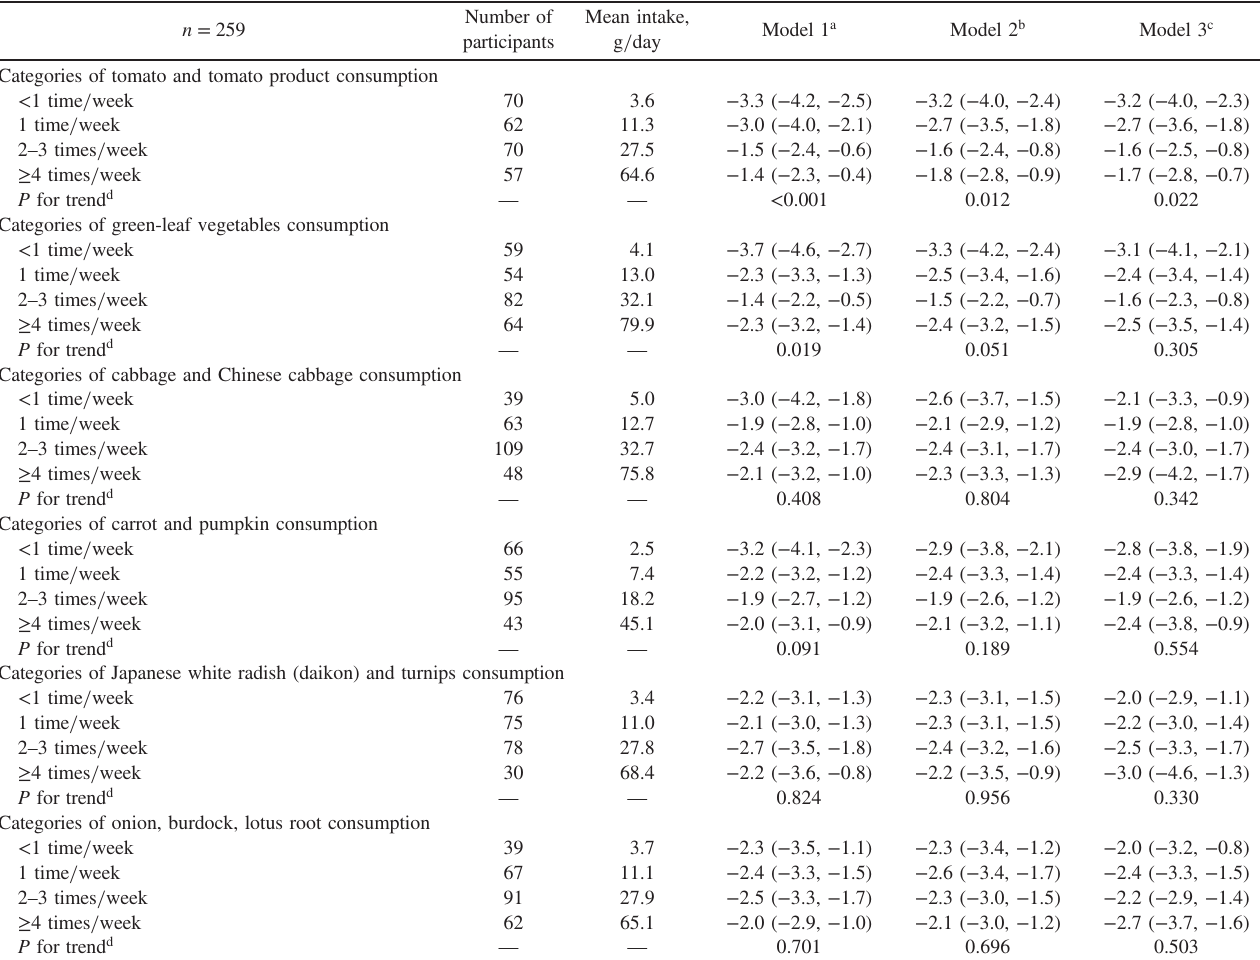
a Model 1: Adjusted for age (continuous variable) at baseline. b Model 2: Adjusted for the variables in model 1 and sex (categorical variable), occupation (categorical variable: desk work or not), smoking status (categorical variable: never, former, or current), drinking frequency (categorical variable: 7 times = week, 1 – 6 times = week and none), PA (continuous variable), sleep duration (categorical variable: 6 – 8 hours or not), BMI (continuous variable), metabolic syndrome (categorical variable: yes or no), hs-CRP (continuous variable), adiponectin (continuous variable), and handgrip strength at baseline. c Model 3: Adjusted for the variables in model 2 and total energy (continuous variable), total protein (continuous variable), calcium (continuous variable), vitamin D (continuous variable) and mutual other types of vegetables (continuous variable) and fruit consumption (continuous variable: citrus fruit; strawberries, persimmon and kiwifruit; apple and banana) at baseline. d Linear trends were assessed using